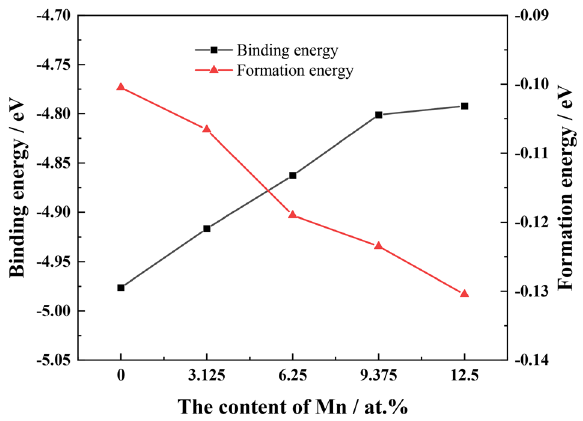
Figure 4. The effect of the Mn content on the formation energy and binding